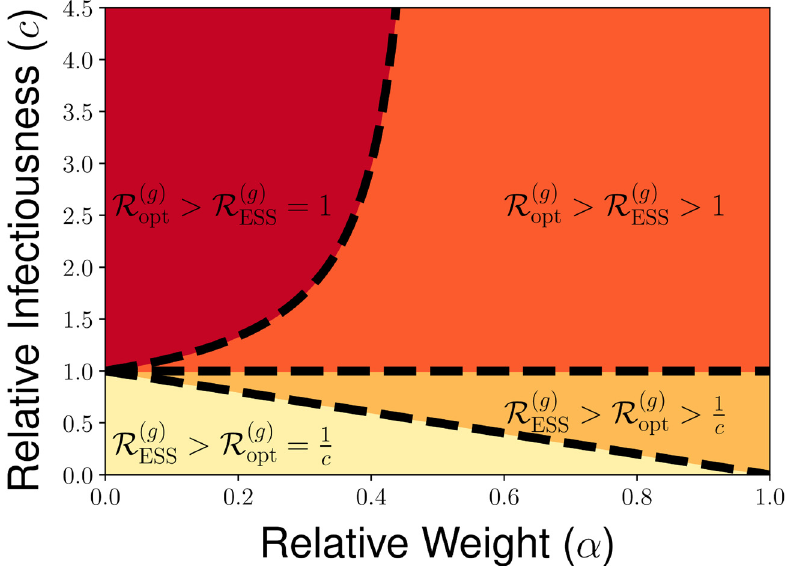
and R ð g Þ across the range of relative levels of opt ESS and R ð g Þ , as well as whether R ð g Þ ¼ 1 or R ð g Þ > 1 ESS opt ESS ESS